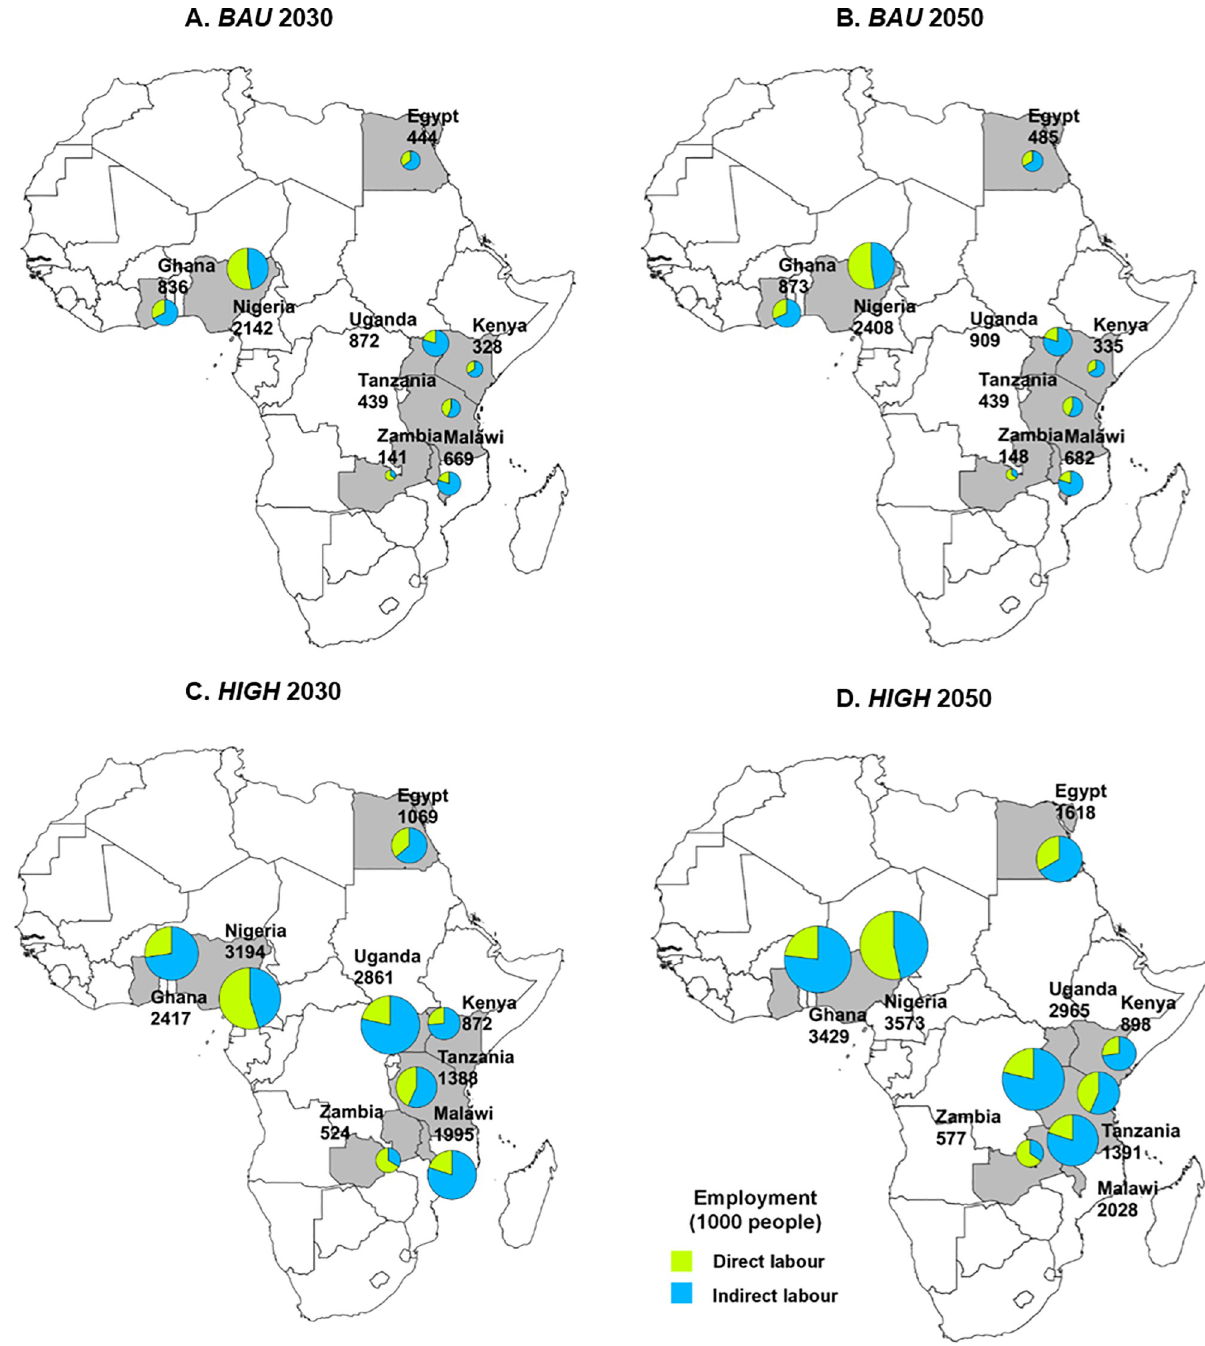
Fig 3. Direct and indirect employment of fish sector under BAU scenario in 2030 (A), BAU scenario in 2050 (B), HIGH scenario in 2030 (C), and HIGH scenario in 2050